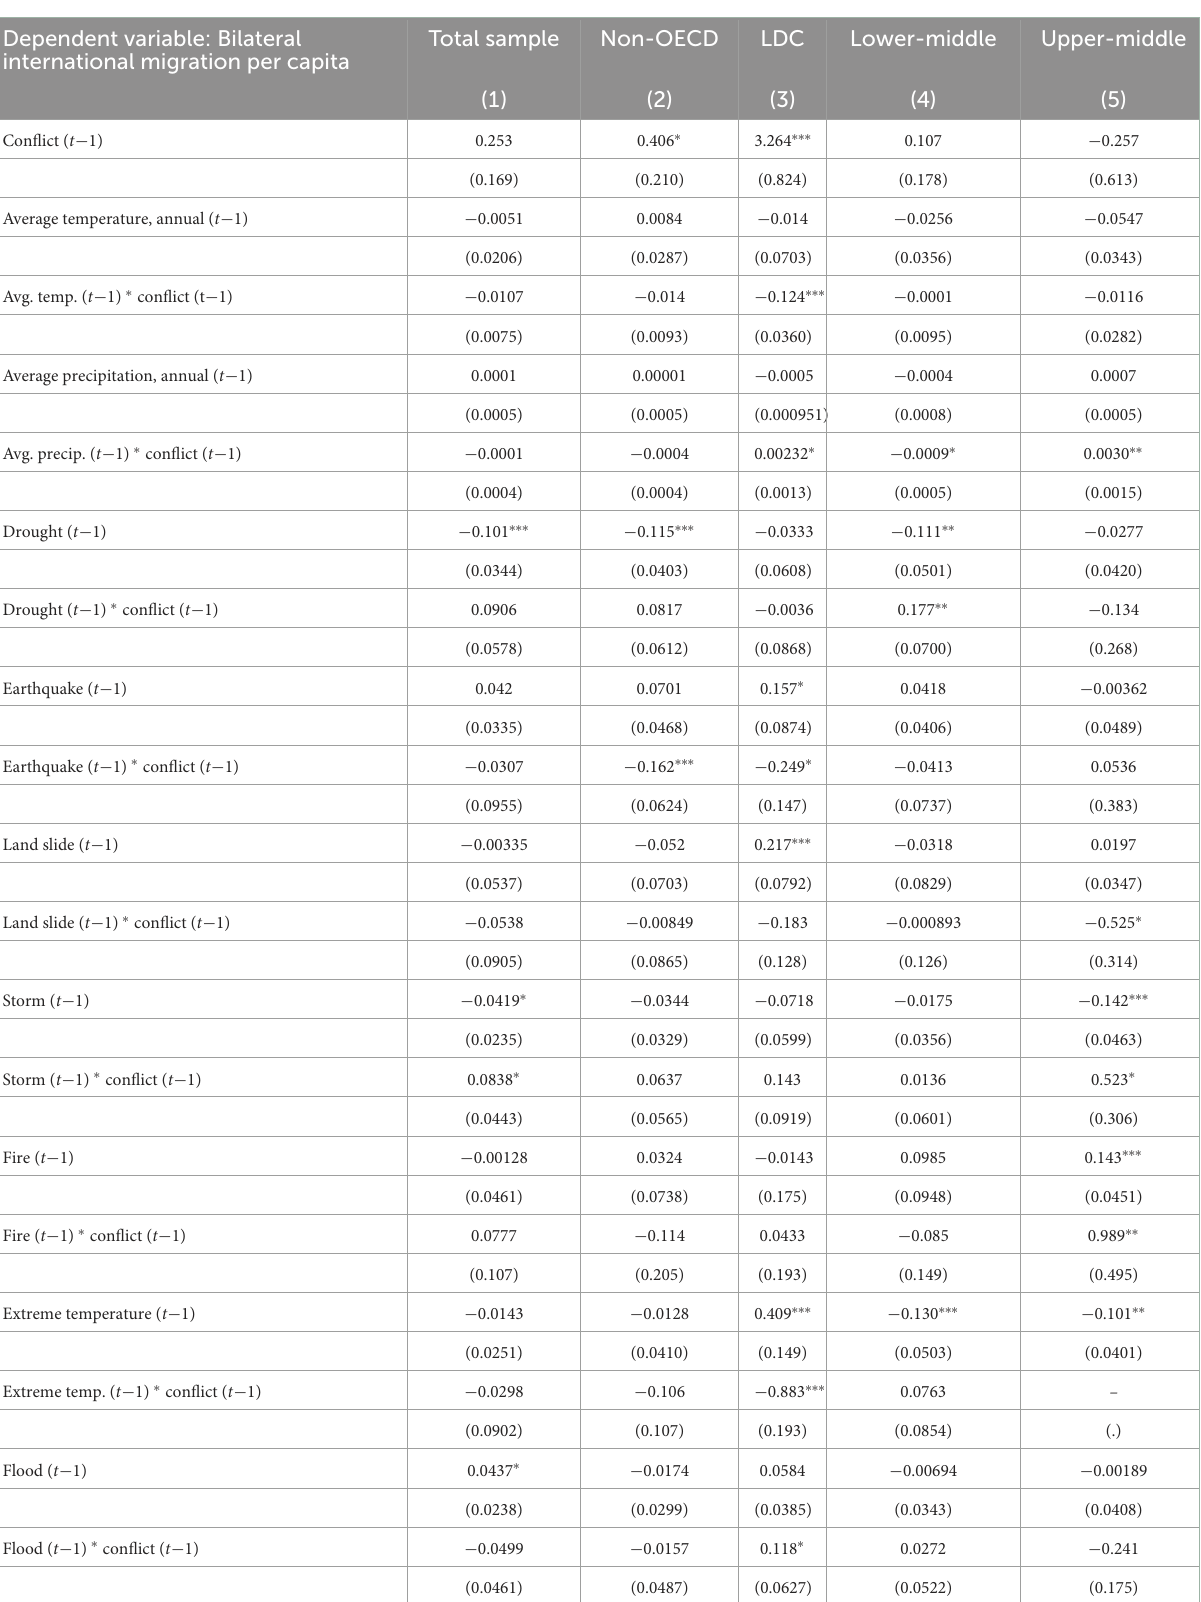
TABLE 5 The impact of climatic events on out-migration in the presence of conflict. Dependent variable: Bilateral international migration per